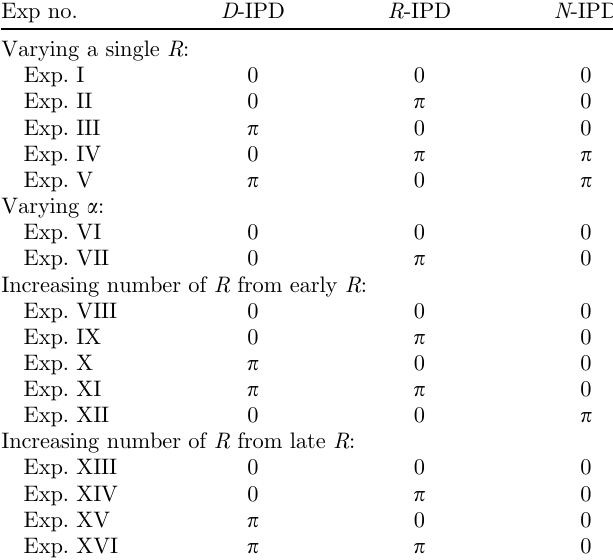
Table 1. Experiment conditions of the data-set [20]: This table shows the IPD of the direct sound ( D ), the re fl ection(s) ( R ), and the noise ( N ) for each experiment. Note that in experiments VI and VII, the ampli fi cation factor ( a ) for the re fl ection was varied between 0 and 2.5. For all other conditions a was set to